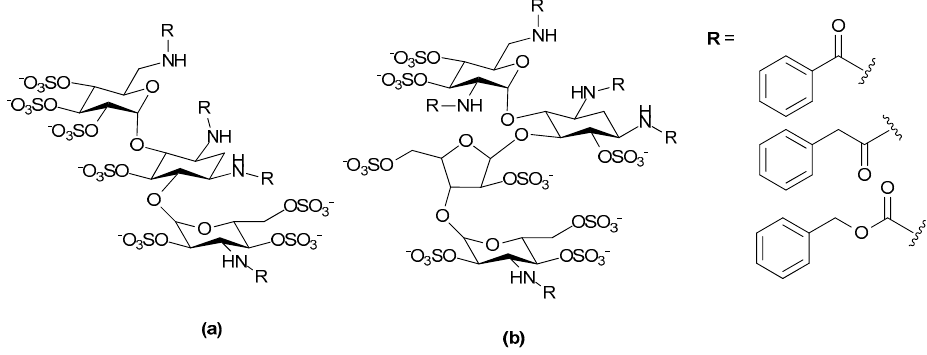
Figure 15. Structure and degree of sulfation of N -arylacyl O -sulfonated aminoglycosides ( a ) Kanamycin core derivatives ( b ) Neomycin core derivatives.